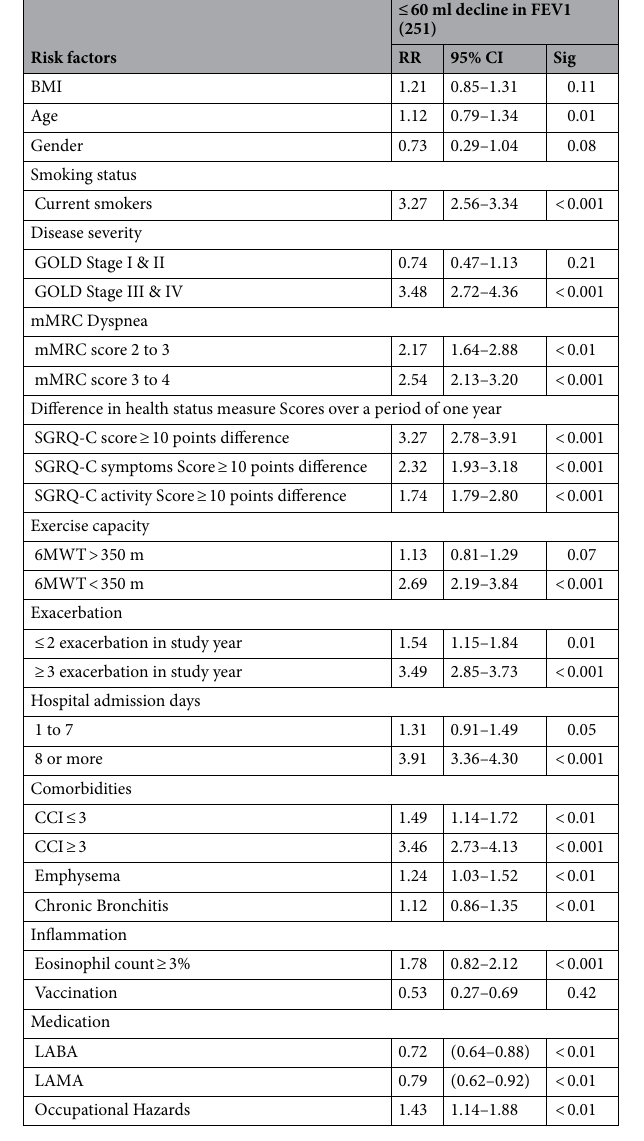
Disease; CCI, Charlson comorbidity Index; FEV 1 , forced expiratory volume in 1 second; FVC, forced vital capacity; FEV 1 %, percentage predicted FEV1; GOLD, global initiative for Chronic Obstructive Lung Disease; GOLD I